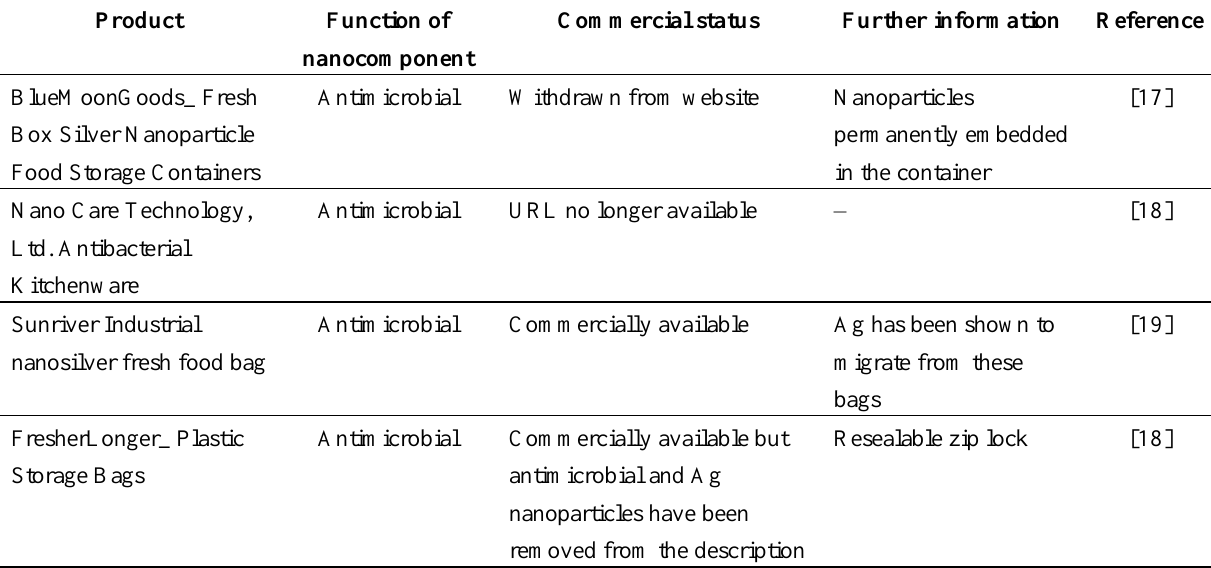
Table 1. Silver nanoparticle use in the food industry ([16],